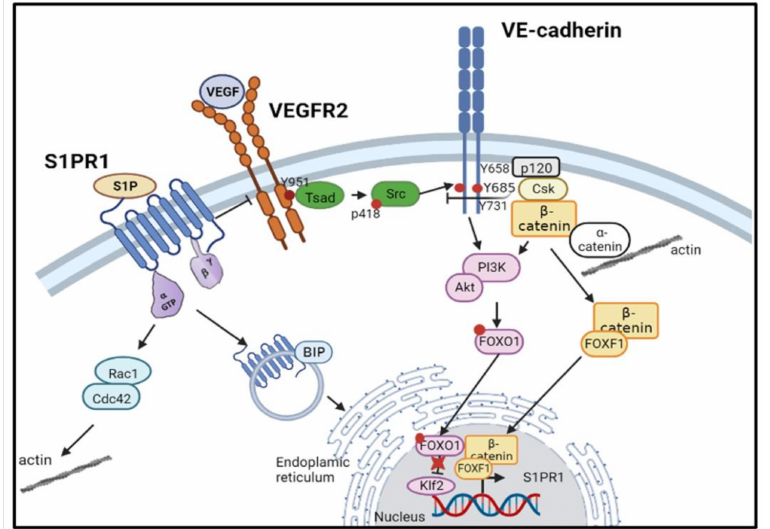
Figure 2. Dialogue between VE-cadherin and sphingosine-1-phosphate receptor 1 (S1PR1) for pro- tecting endothelial